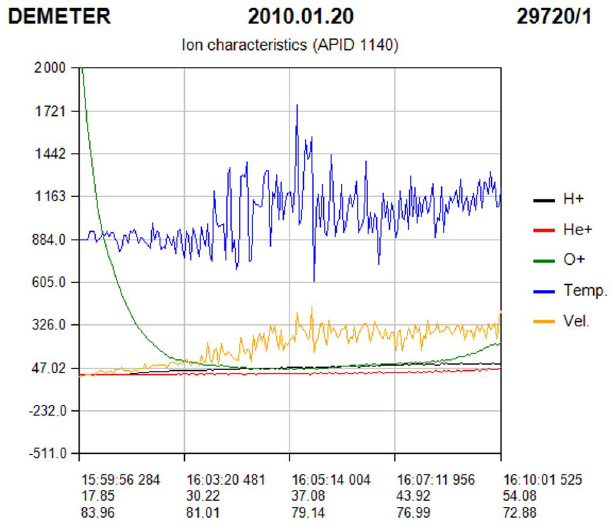
Figure 10. Temperature, velocity and density and of ions at satellite height for half orbit no.